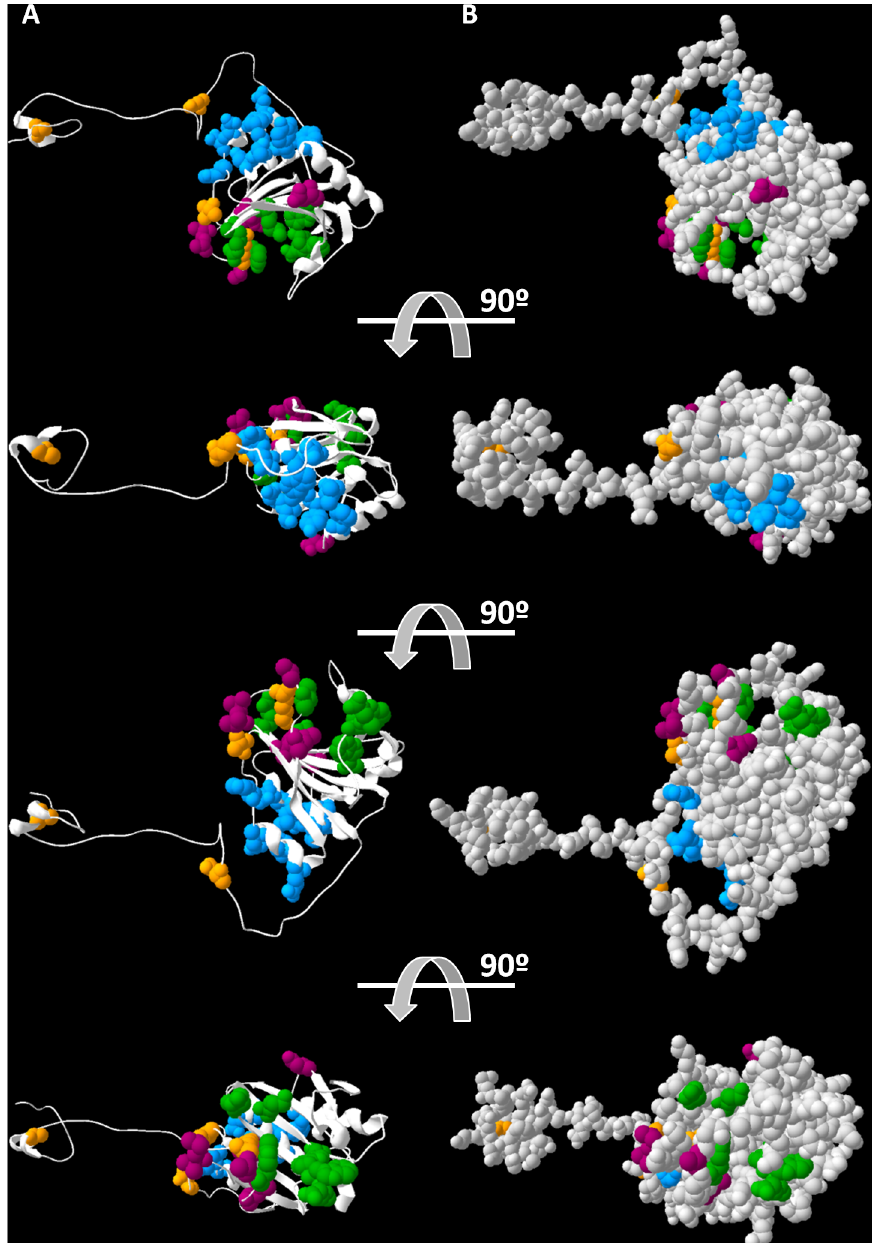
Fig 5. 3D-model of the pvr2/eIF4E1 protein structure. The localisation of the polymorphic positions identified in chiltepin populations (orange), sites involved in potyvirus resistance (purple), sites involved in the m7GTP cap recognition (green) and the domain of eIF4G interaction (blue) are indicated. (A) 3D-model representing the secondary structure of pvr2/eIF4E1 protein. (B) 3D-model representing the Van der Waals surface of pvr2/eIF4E1